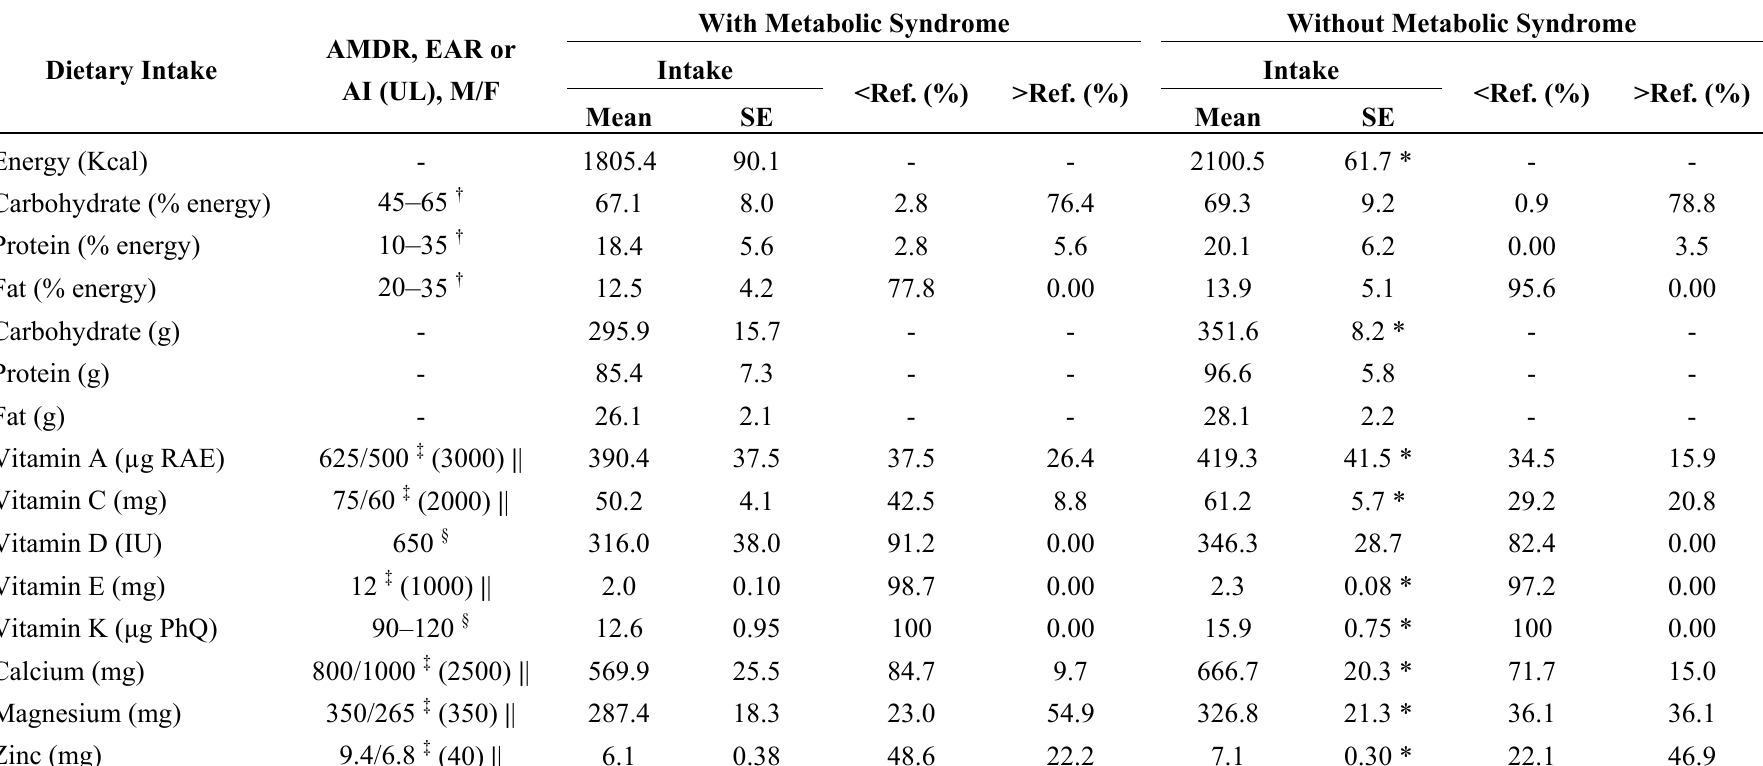
Table 2. Daily dietary intakes of selected nutrients of study participants based on reference (ref.)